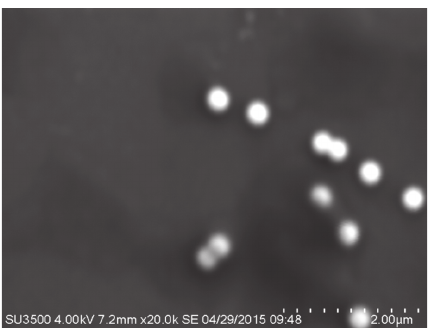
a Molar ratio of comonomers in the microsphere by 1 H-NMR. b Determined by reflectance spectrometer. c Determined using Bragg’s equation [15].